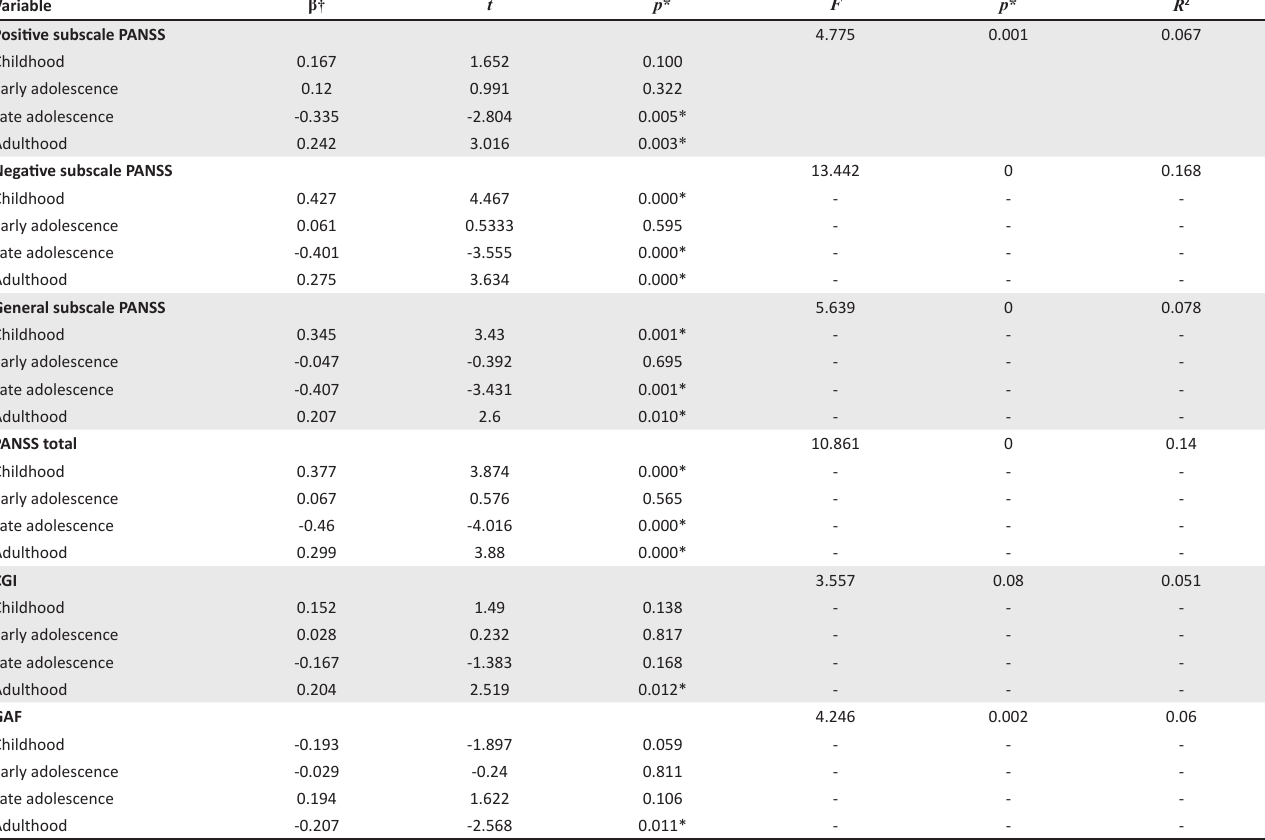
TABLE 5: Linear regression modelling of the association between socio-sexual stages of premorbid adjustment and illness severity.